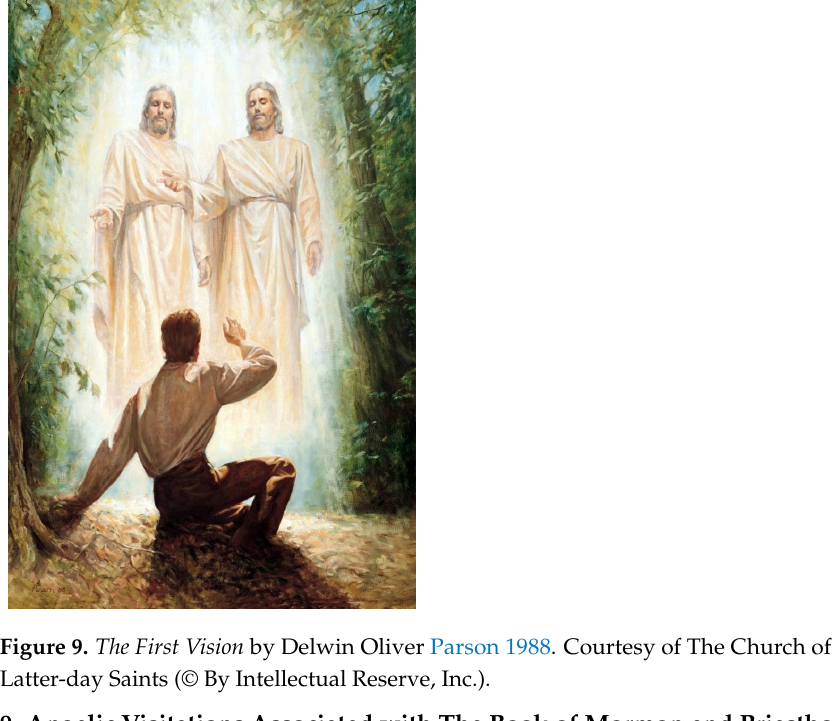
Figure 8. Joseph Smith’s First Vision by Unknown Artist, 1873. Published in Thomas Brown Holmes